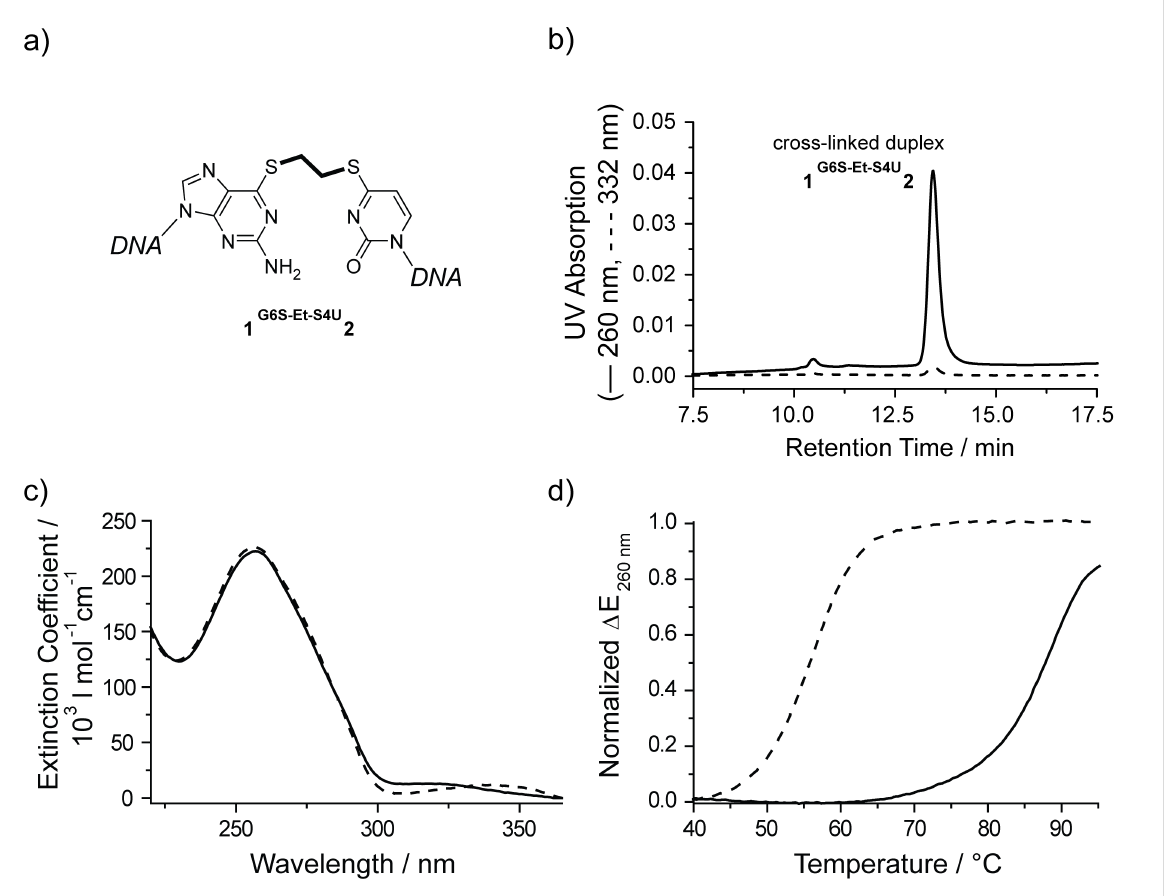
Figure 3: Characterization of HPLC-purified cross-linked duplex 1 G6S-Et-S4U 2 (a) by denaturing anion exchange HPLC (b). Alkylation at the sulfur atoms within the thionucleobases is confirmed by the strong reduction of the absorption band above 300 nm in the UV spectrum of 1 G6S-Et-S4U 2 (c, solid) compared to the spectrum of 1 G6S ∙ 2 U4S (dashed). The thermal stability of the cross-linked duplex 1 G6S-Et-S4U 2 (d, solid) is drastically increased compared to 1 G6S ∙ 2 U4S (dashed).